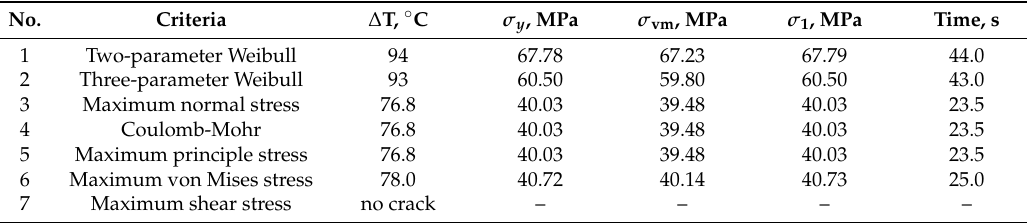
Table 2. Time to first crack predicted by various criteria.